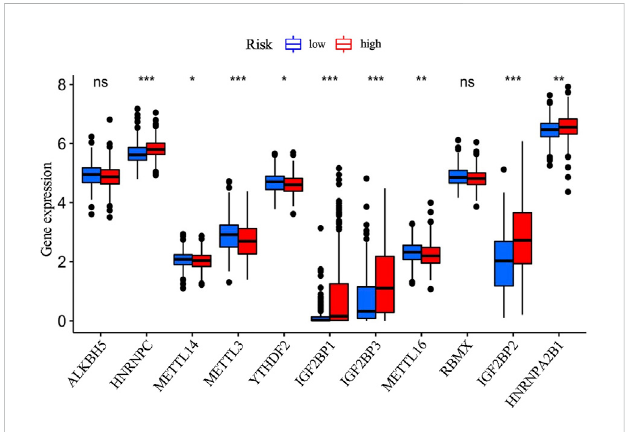
FIGURE 6 The comparative analysis of the m6A-related gene expressions between the high- and the low-risk groups.